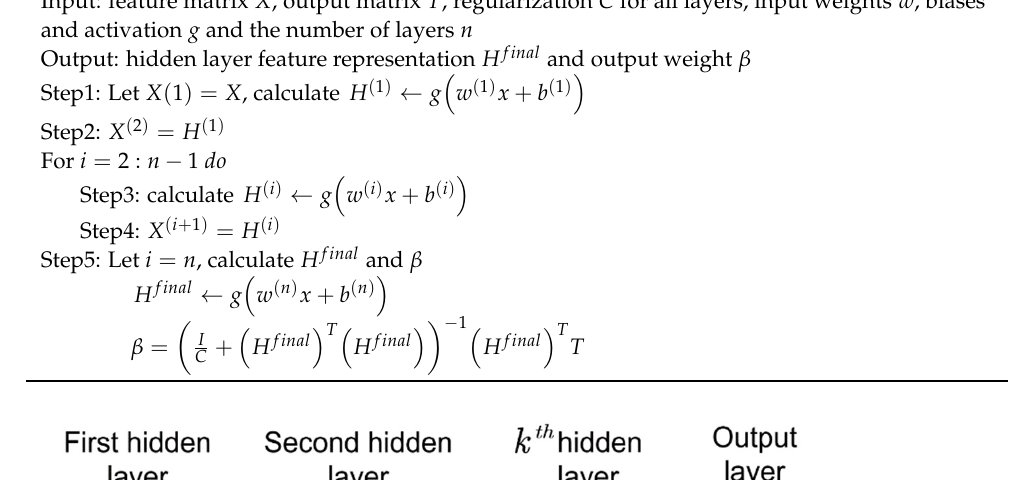
Algorithm 1. Pseudocode for multiple hidden layer ELM.